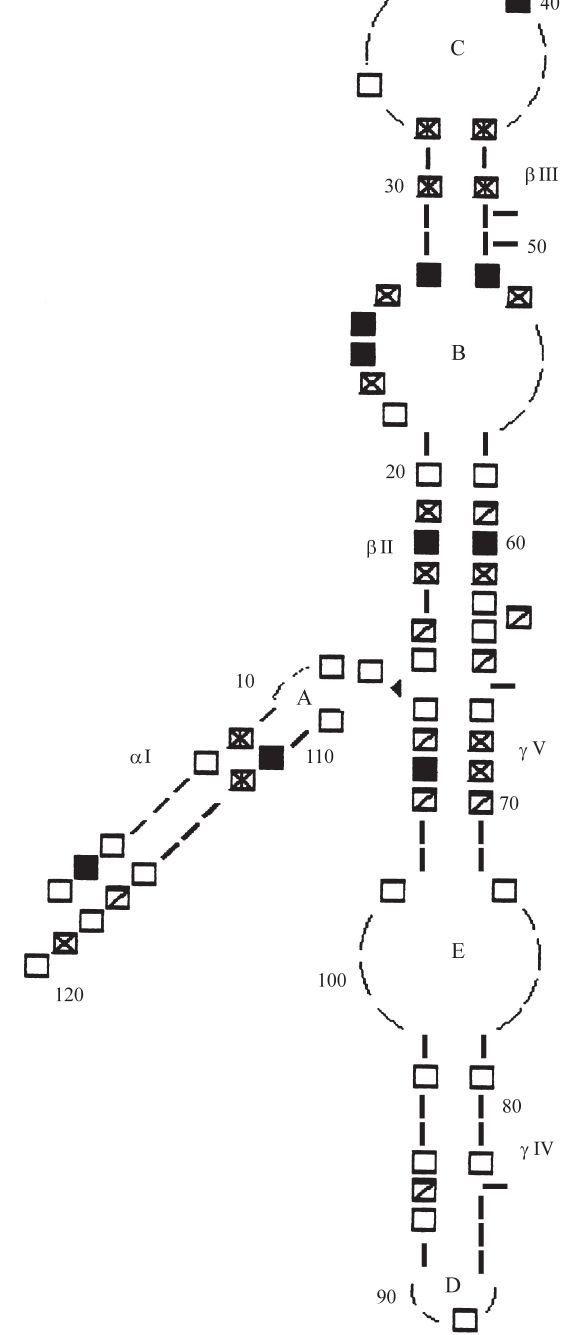
Figure 5 - Location and frequency of bases different in other deute- rostomes from the 5S rRNA of mammals. Frequency (%) per molecule: